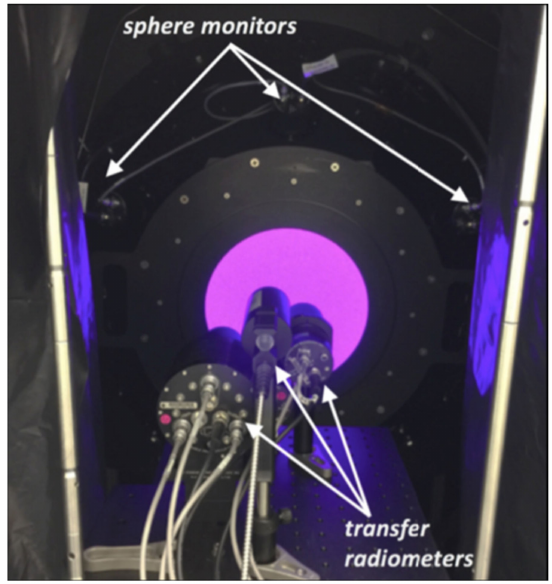
Figure 9. Photo showing the Goddard Laser for the Absolute Measurement of Radiance (GLAMR) integrating sphere with the National Institute of Standards and Technology (NIST)-calibrated transfer radiometers mounted at the sphere’s exit port. The location of the sphere monitors, permanently mounted to the sphere and staring at the back of the sphere, is